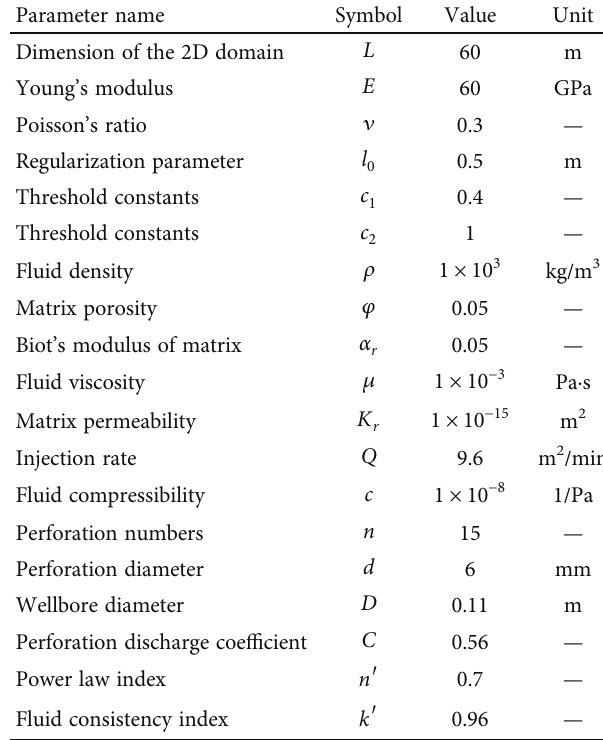
Table 3: Numerical model